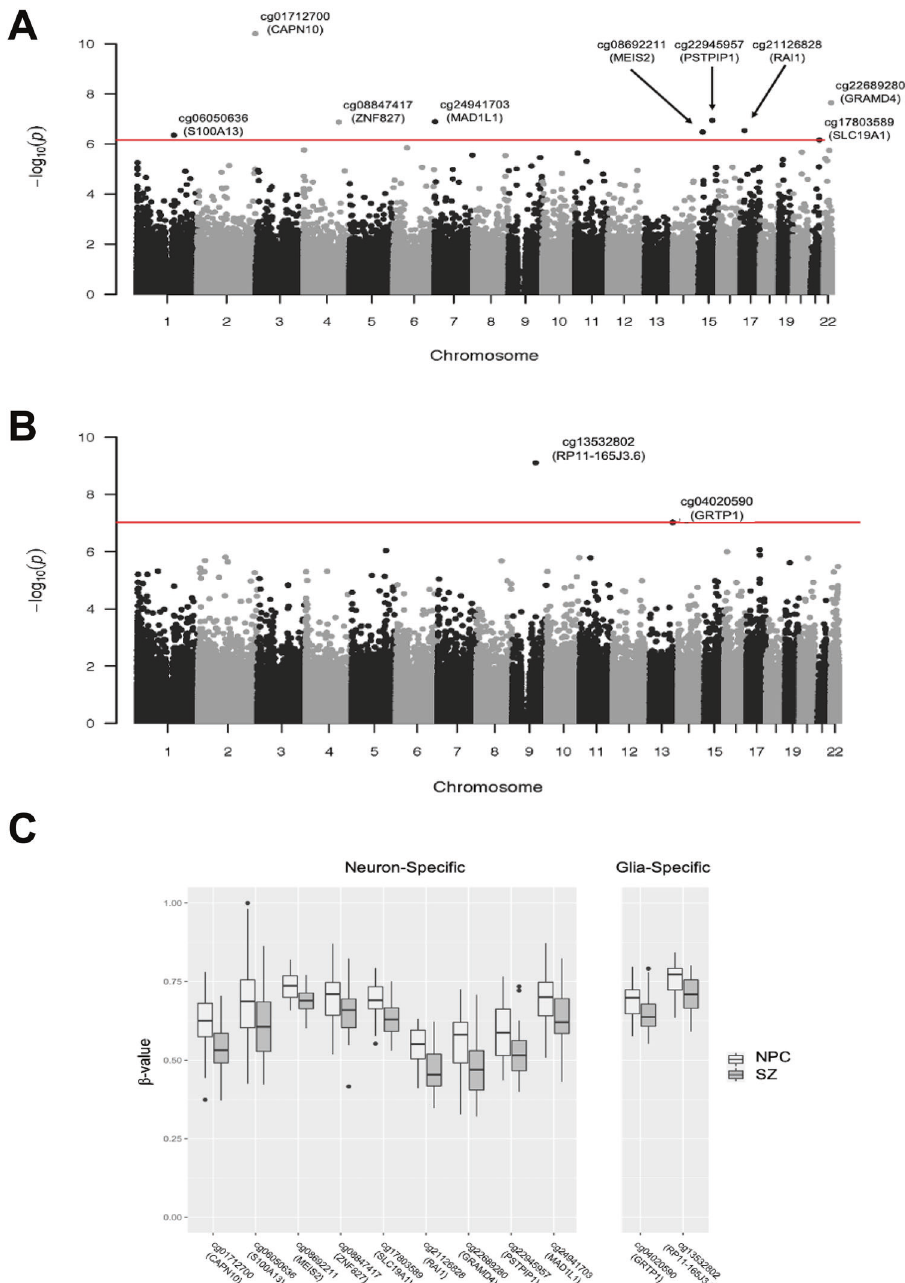
Fig. 2 Neuron- or glia-speci fi c differential methylation in SZ. A Manhattan plot showing neuron-speci fi c DNAm differences between SZ and NPC subjects at nine sites. B Manhattan plot showing glia-speci fi c DNAm differences between SZ and NPC subjects at two sites. C Box plots of DNAm ( β value) at sites of cell-type-speci fi c differences in DNAm between SZ and NPC subjects. DNAm DNA methylation, SZ schizophrenia, NPC non-psychiatric